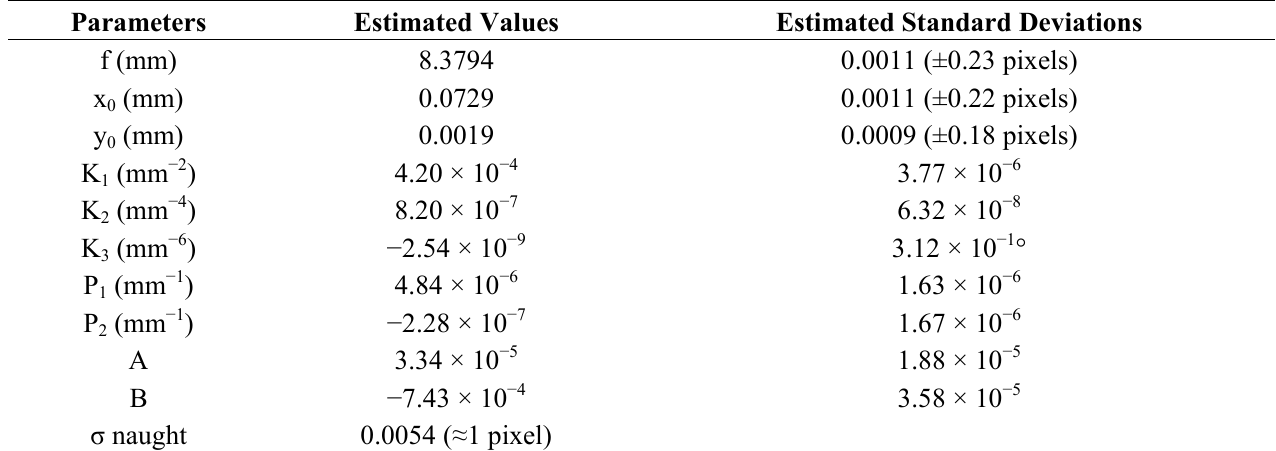
Table 2. interior orientation parameters (IOPs) estimated in the calibration process via bundle adjustment with the equidistant